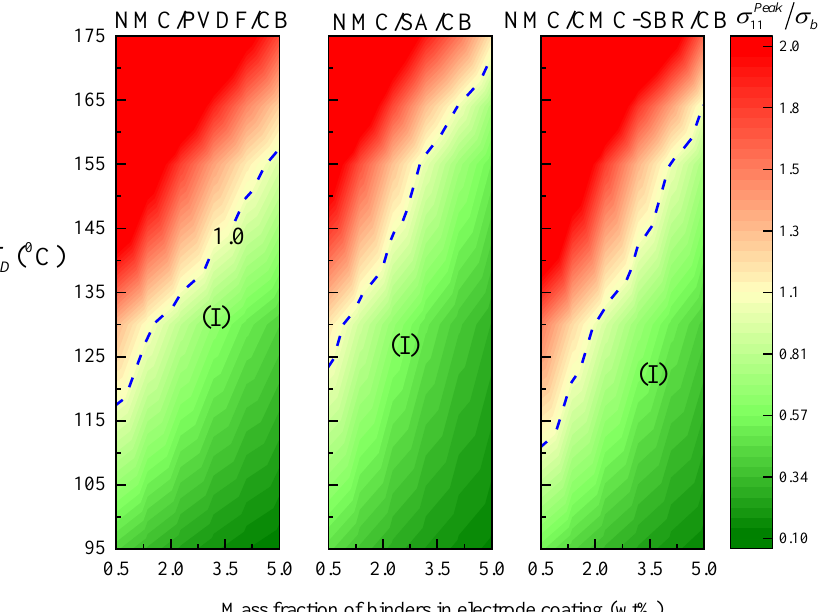
Figure 9. Effect of binder content in electrode composite on mechanical integrity of dried coating film.